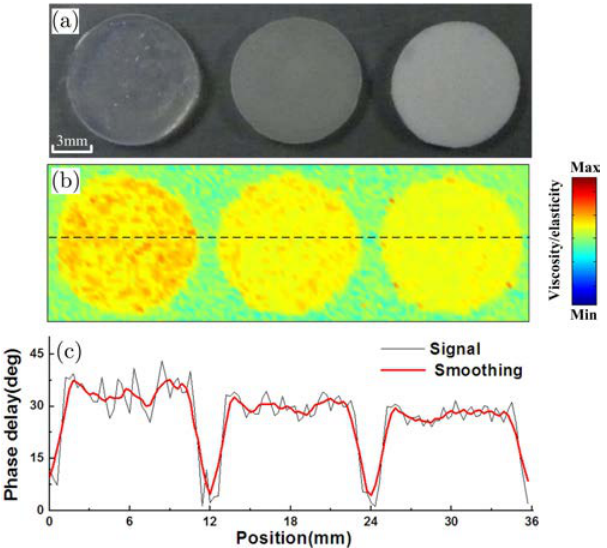
Fig. 3. (a) Photograph of the gelatin phantoms with the gelatin density of 1%, 5% and 10%, respectively. (b) The PAVEI of gelatin phantoms with di®erent viscoelastic proper- ties. (c) Reconstruction pro¯les of PAVEI image at the position indicated by dashed lines.